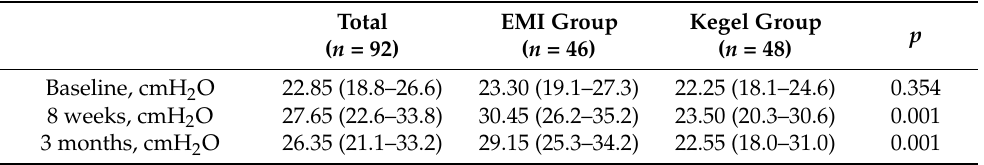
Table 3. Determination of intravaginal pressure by perineometer and comparison between EMI and Kegel groups with its respective interquartile range (25th and 75th